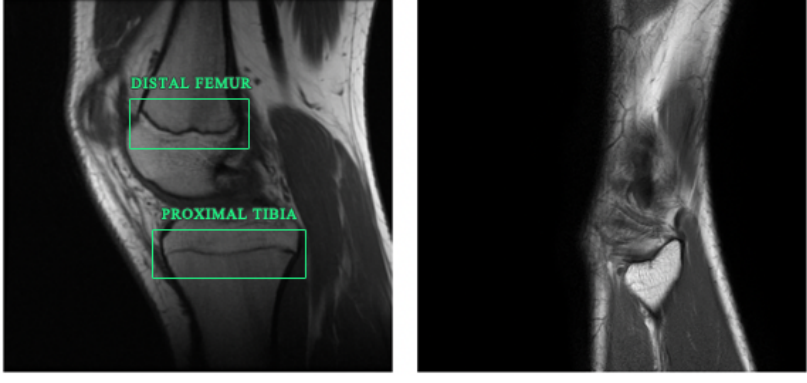
Figure 2. Examples of informative and noninformative images from the same subject.